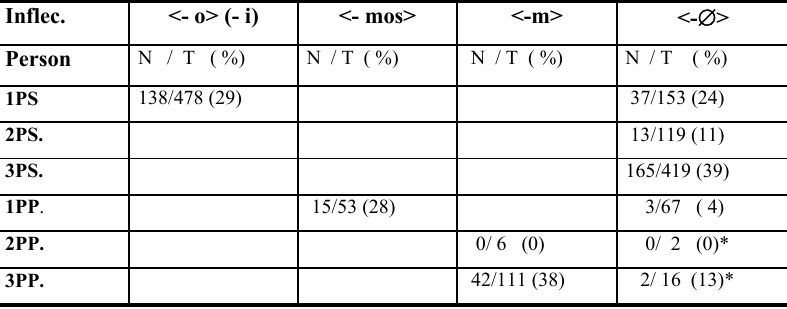
Table III – Null subjects vs inflection and grammatical person – graduates (Adapted from Duarte, 1995:56)